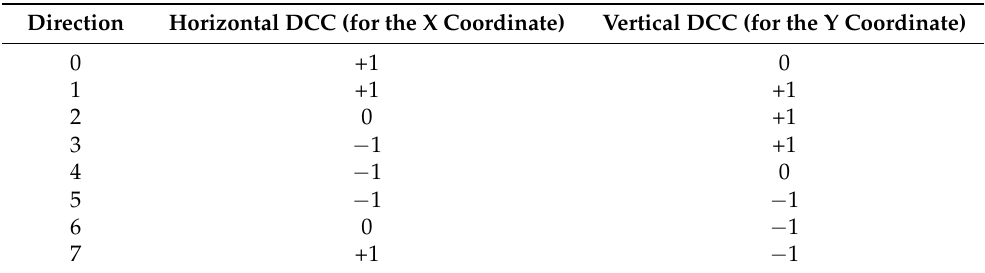
Figure 8a, if the pink contour point nearest to the origin of the image is taken to be the start point of chain-code tracing, the corresponding sequence of coherent chain-code segments are {(0, 1), (1, 1), (2, 4), (3, 2), (5, 2), (6, 1), (7, 1), (6, 1), (7, 1), (6, 1)}. Additionally, the sequences of the horizontal and vertical DCCs can, respectively, be calculated to be: